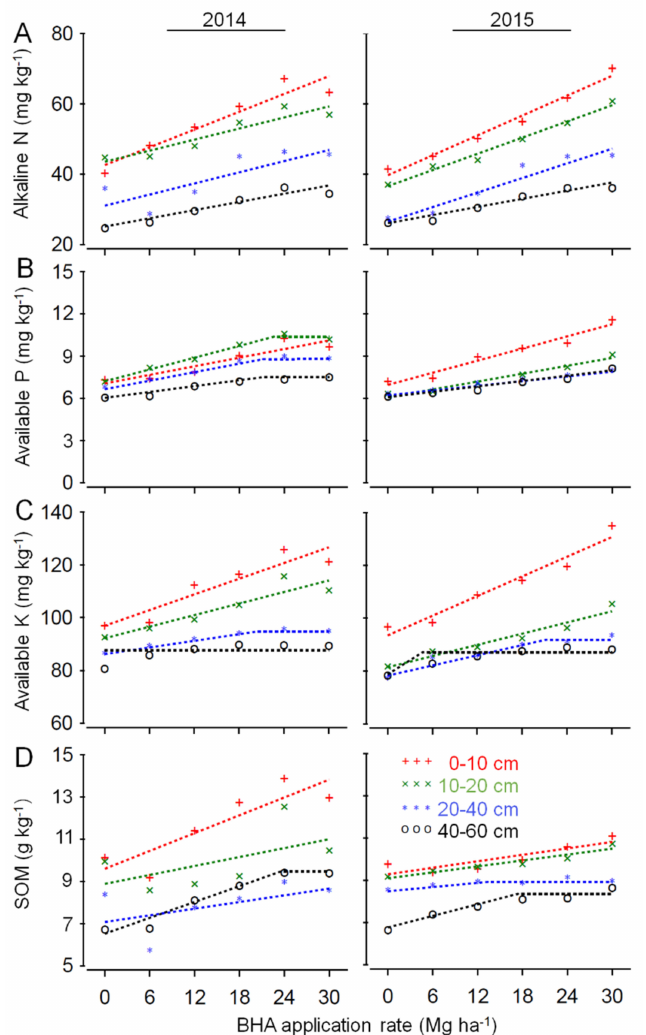
Figure 3. Means of ( A ) soil alkaline nitrogen (AN), ( B ) available phosphorus (AP), ( C ) available potassium (AK), and ( D ) organic matter measured at crop harvest in 2014 and 2015 in the 0–60 cm soil profile plotted against one-time bentonite-humic acid (BHA) application rate. The response of dependent variable (Y) to the BHA application rate (X) for each was fitted individually to a separate piecewise linear plus plateau model (dotted lines). The slopes of the regression lines were significant ( p < 0.05) for all parameters, except 40–60 cm for AK in 2014. Colors indicate different soil depths in all panels: 0–10 cm (red plus), 10–20cm (green × ), 20–40 cm (blue asterisk), and 40–60 cm (black